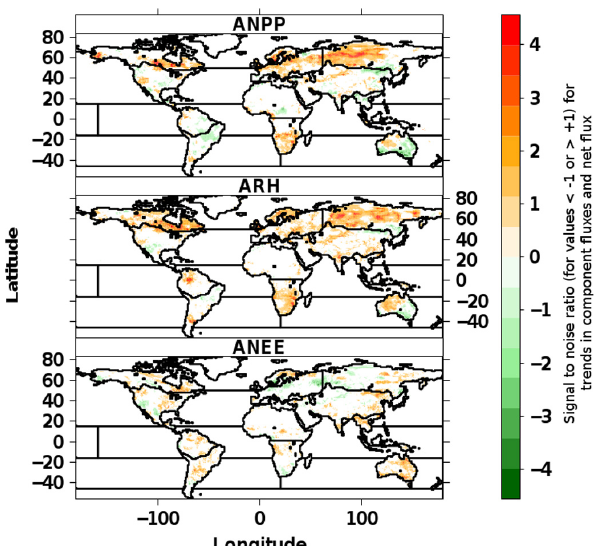
Fig. 4. Signal to noise ratio (for values < − 1 or > + 1) for annual net primary production (ANPP), heterotrophic respiration (RH), and net ecosystem exchange (NEE). A positive value for NPP and RH indicate increasing rates and a positive value for NEE indicates a trend toward a carbon